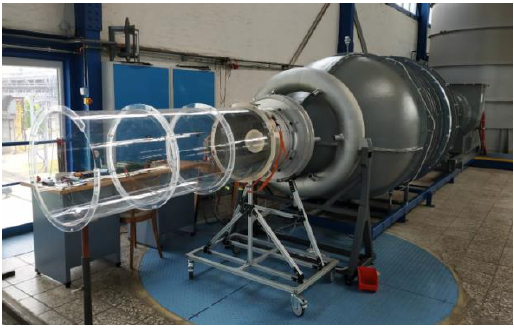
Fig. 2. Exhaust hood model with extension pipe.